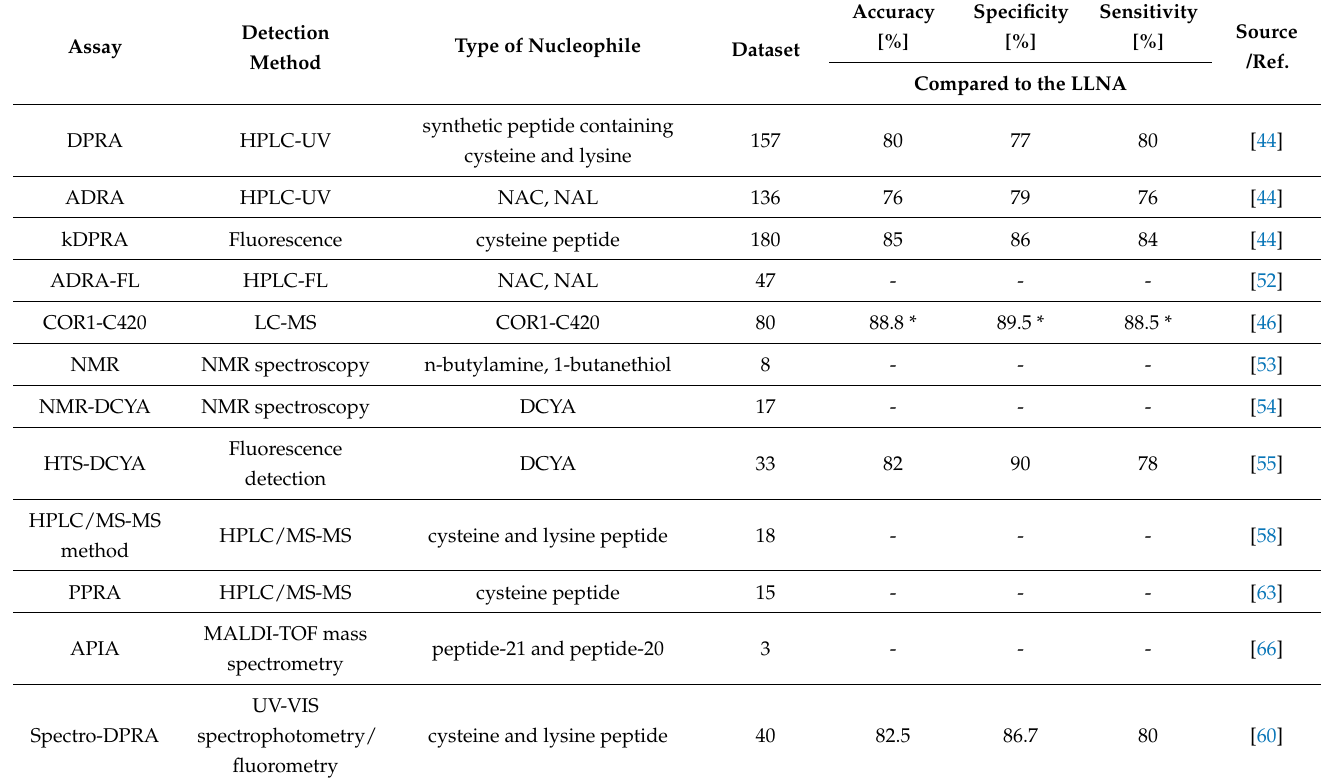
Table 2. KE1. Summary of